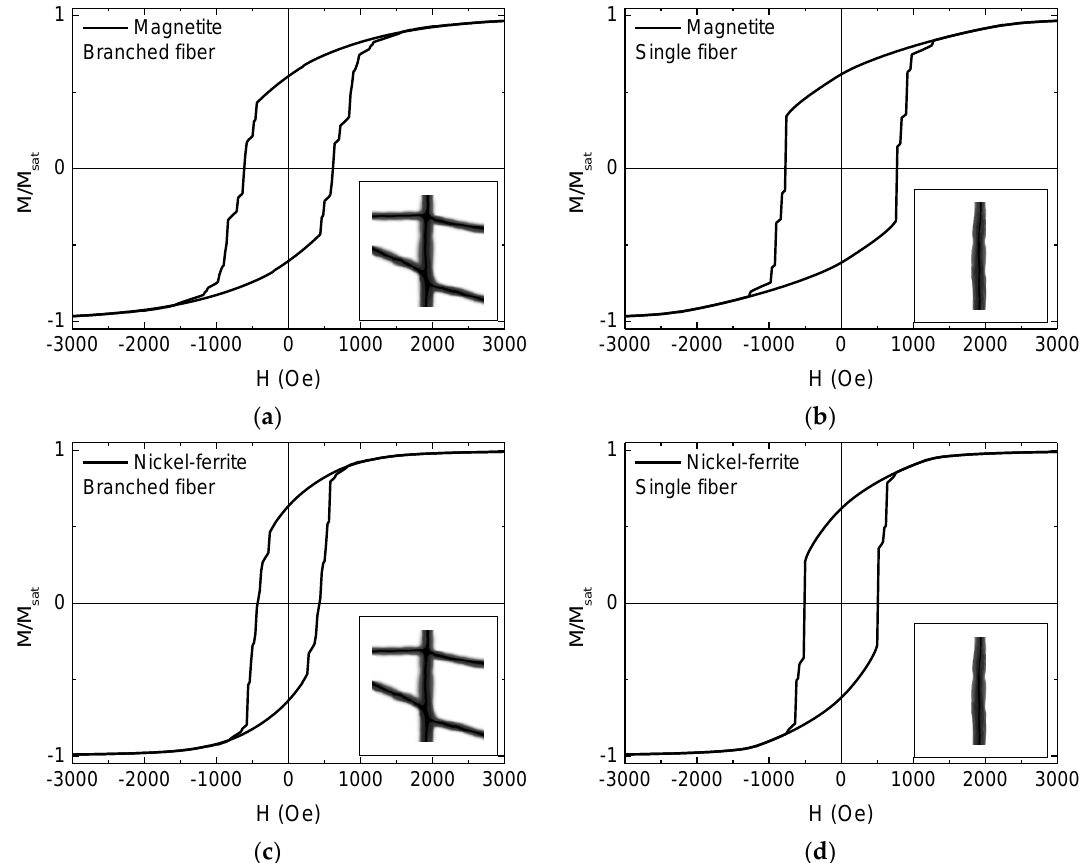
Figure 9. Simulated hysteresis loops of ( a ) magnetite branched fiber; ( b ) magnetite single fiber; ( c ) nickel-ferrite branched fiber; ( d ) nickel-ferrite single fiber.